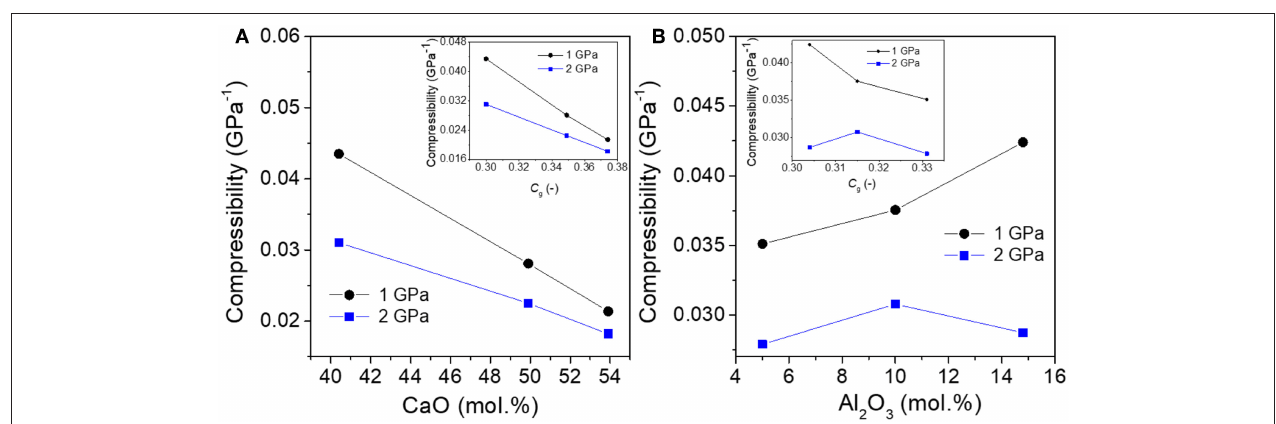
FIGURE 7 | Plastic compressibility ( β ) of compressed glasses as a function of the molar concentration and atomic packing density ( C g ) (inset) of (A) CaO and (B)